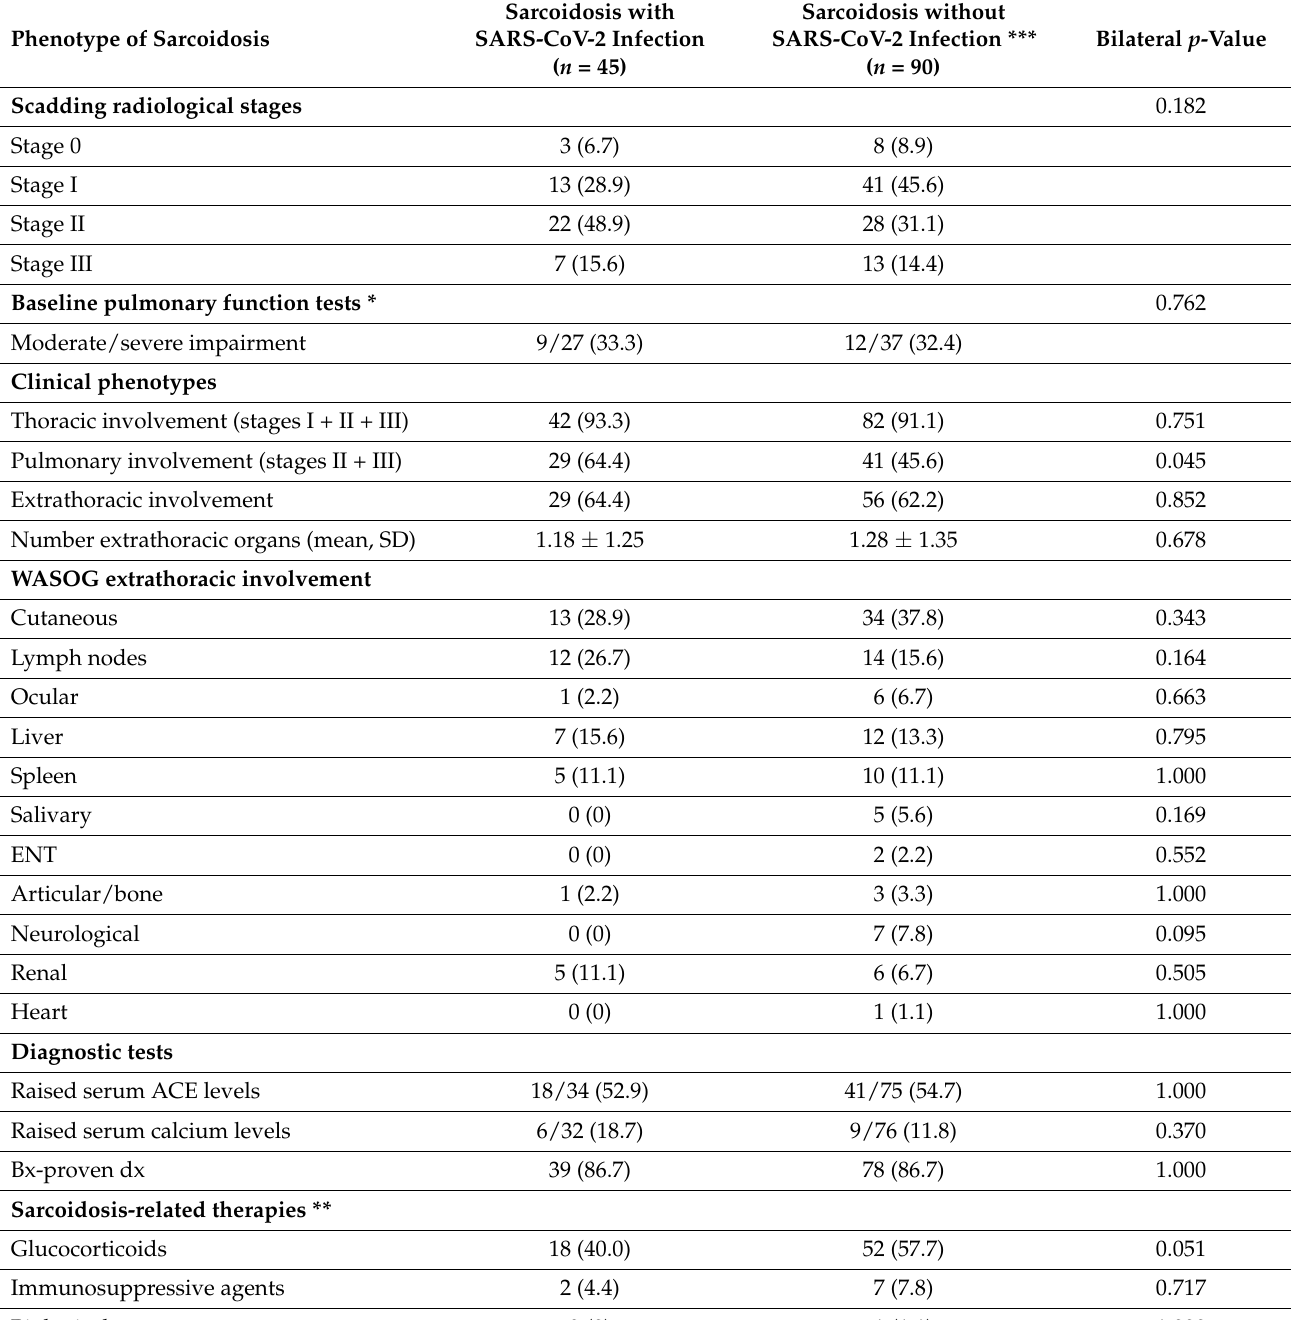
Table 3. Phenotype of sarcoidosis in patients with and without SARS-CoV-2 infection (1:2 age-sex-matched case control